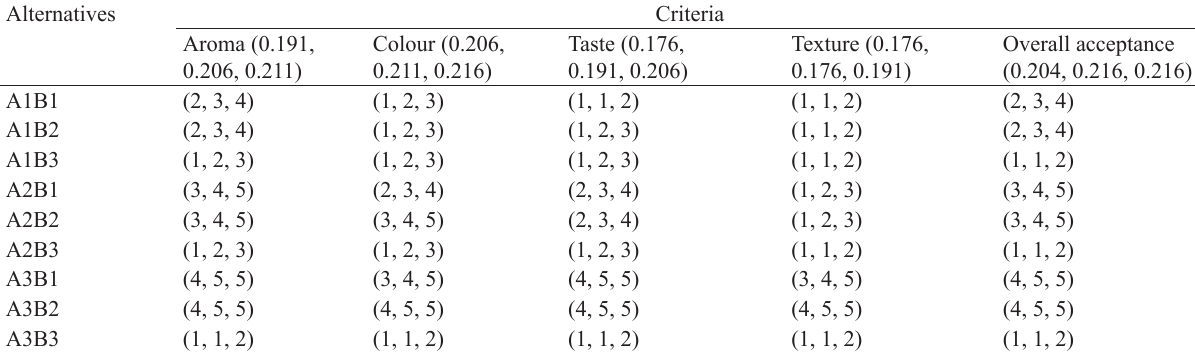
Table 9 Matrix of respondents’ assessment on alternative in TFN